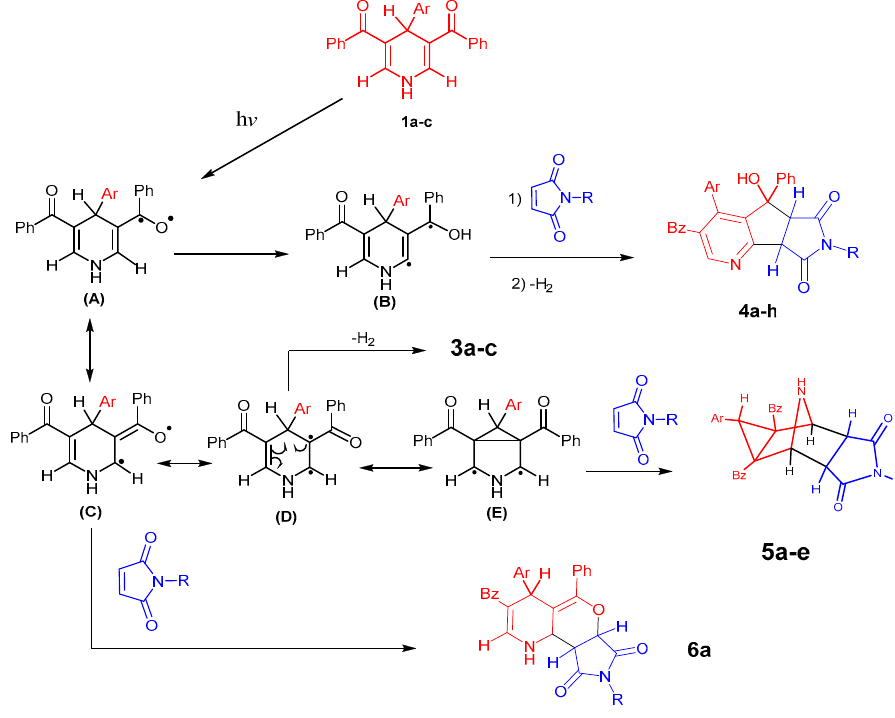
Scheme 3. The diradical photoreaction mechanism.